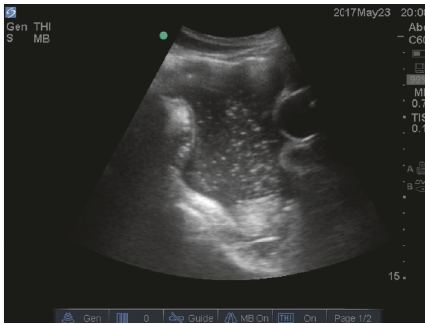
Figure 3: Lesion noted to the left anterior thigh with charred edges, possibly representing a burn.